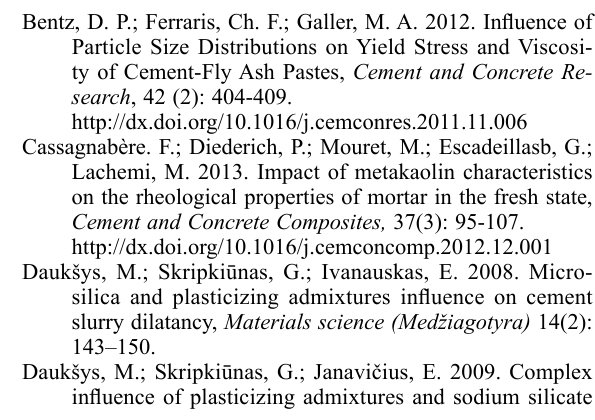
particlesa) Fig. 6. Microscopy images of different cement particles: a – Portland cement particles; b – Slag cement